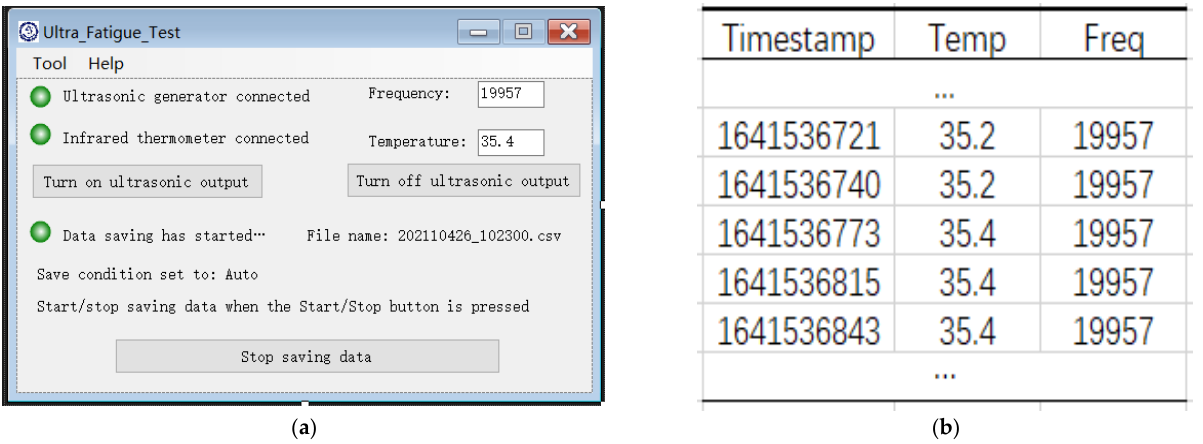
Figure 14. Computer control system: ( a ) Control system interface; ( b ) screenshot of test data.